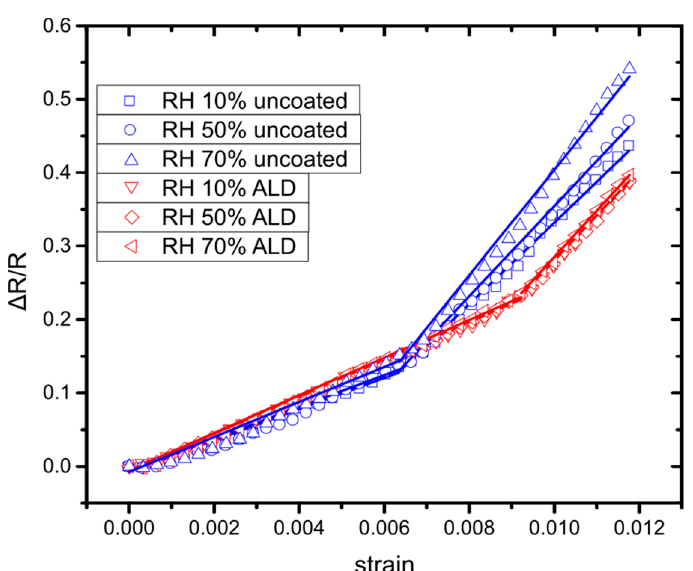
Figure 10. Performance of a sensor before alumina coating (uncoated) and right after the alumina coating (ALD) for RH conditions of 10%, 50% and 70%. The fitting lines for the uncoated sensor are the blue ones, while the red ones indicate the coated one.